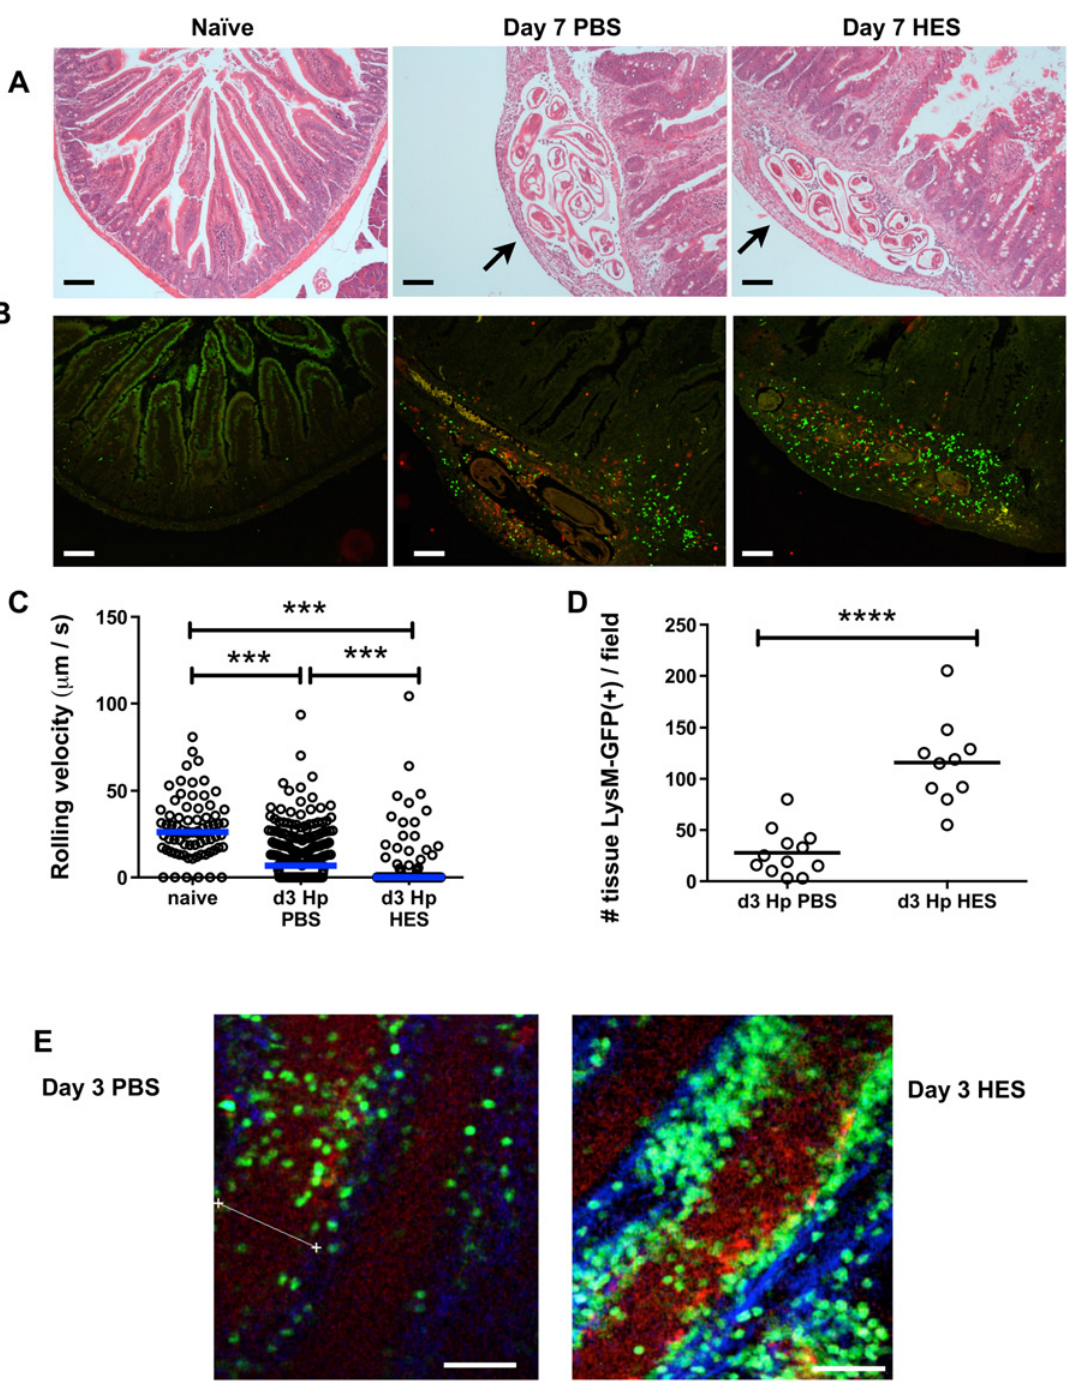
Fig 2. HES vaccination promotes extensive myeloid cell extravasation and accumulation around site of larval invasion. A . H&E staining of duodenal sections from na ï ve and d 7 post-challenge PBS control or HES-immunized C57BL/6 mice. Arrows indicate position of parasites. B . Immunohistology showing recruitment of CD11b + (green) and Gr1 + (red) myeloid cells. Representative of 3 – 4 mice per group. Scale bar in A-B represents 100 μ m. C . Rolling velocities of LysM-GFP + cells along vessels imaged by two-photon microscopy of duodenum from the serosal aspect. Data accumulated from two mice per group, 3 – 7 vessels per mouse. Vessels were selected on basis of showing rolling behaviour. Significance determined by Kruskal-Wallis test. D . Tissue infiltration of LysM-GFP + cells surrounding vessels in (C). Significance determined by t -test. E, F . Examples of two-photon microscopy from (D) showing tissue-infiltrating LysM-GFP + cells in PBS- and HES-vaccinated mice. Scale bar represents 50 μ m. See also Supplemental Movie S1.